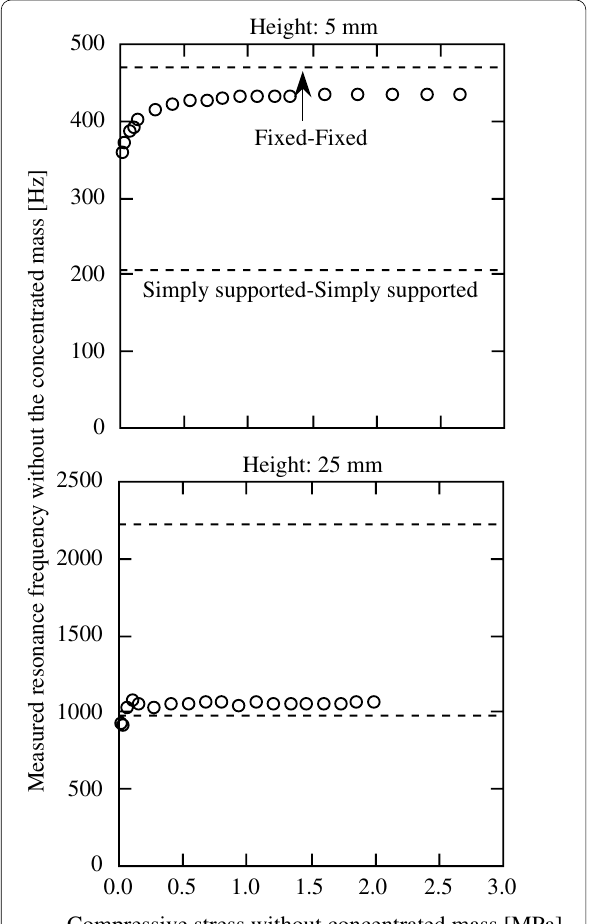
Fig. 5 Example of the changes in the measured resonance frequency without the concentrated mass during the increase in compressive stress